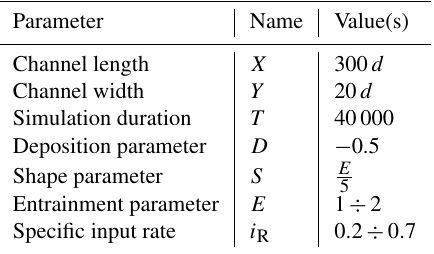
Table 1. Values of the parameters used in the steady-state simula-